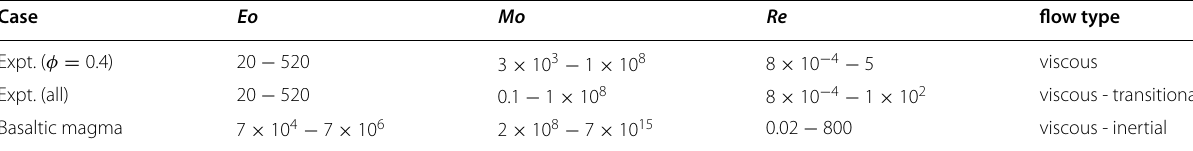
Table 2 Dimensionless numbers for a rising bubble : the Eötvös Eo = �ρ gd 2 be /σ (bubble size, Eq. (4)), the Morton Mo = g η 4 /ρσ 3 (fluid property), and the Reynolds Re = ρ Ud be /η (bubble velocity) numbers (see Tables 3, 4 for notations). For magma, η = 230 − 1.7 × 10 4 Pas (Additional file 7: Material), d be = 1 − 10 m are assumed and the Re is calculated from the Eo , Mo using an empirical function (Clift et al.